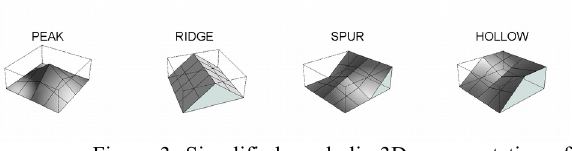
Figure 3: Simplified symbolic 3D representation